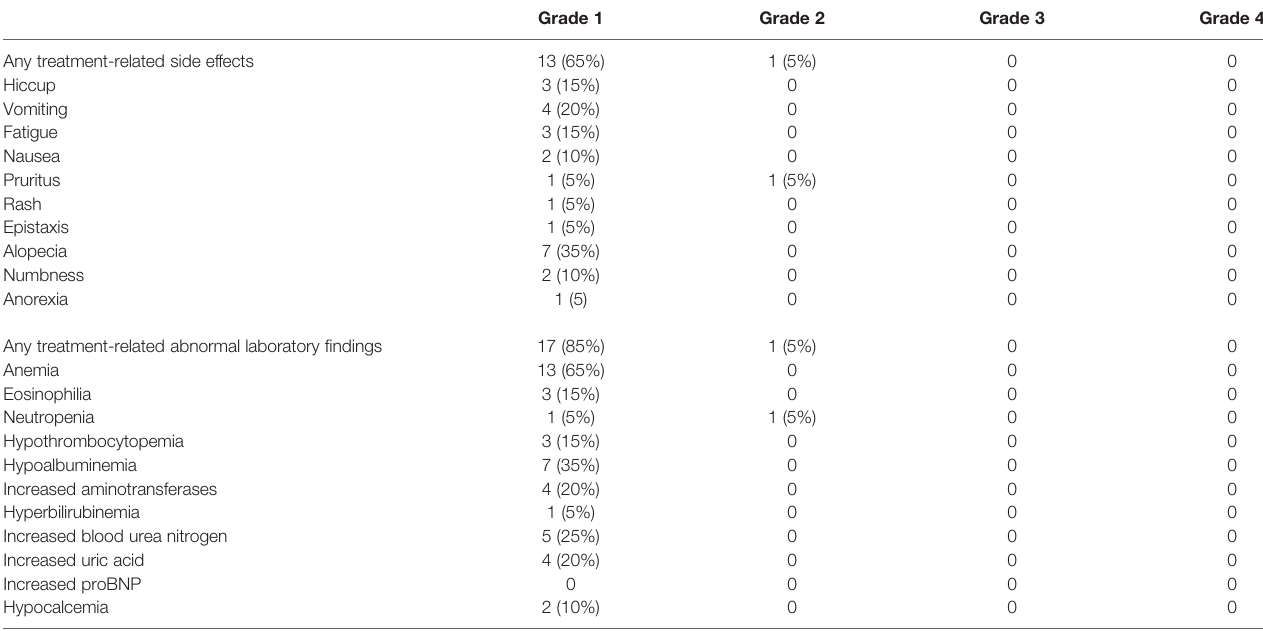
TABLE 4 | Toxicity pro fi le of the included